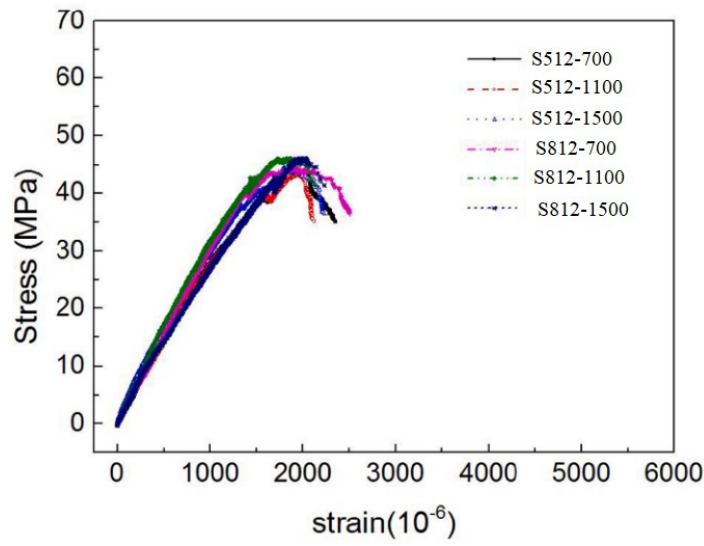
Figure 2. Stress–strain curve for all tested specimens.